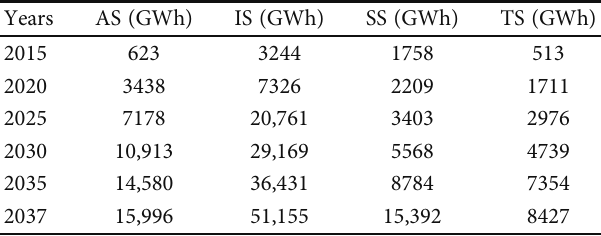
Figure 3: Ethiopia exploited and unexploited energy potentials [19] (Ng: natural gas; Sol: solar; Geo: geo thermal; Win: wind; BiM: biomass; HyP: hydropower; R: reserved). Table 1: Energy demand forecast from 2015 to 2037 in a di ff erent sector. AS(GWh), IS (GWh), SS (GWh), and TS (GWh).